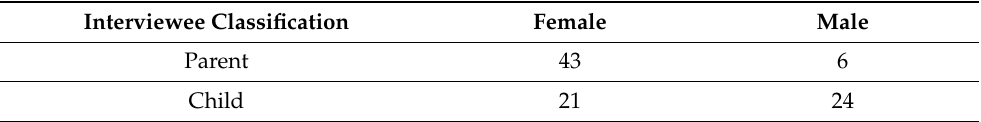
Table 1. Demographics of the sample set by